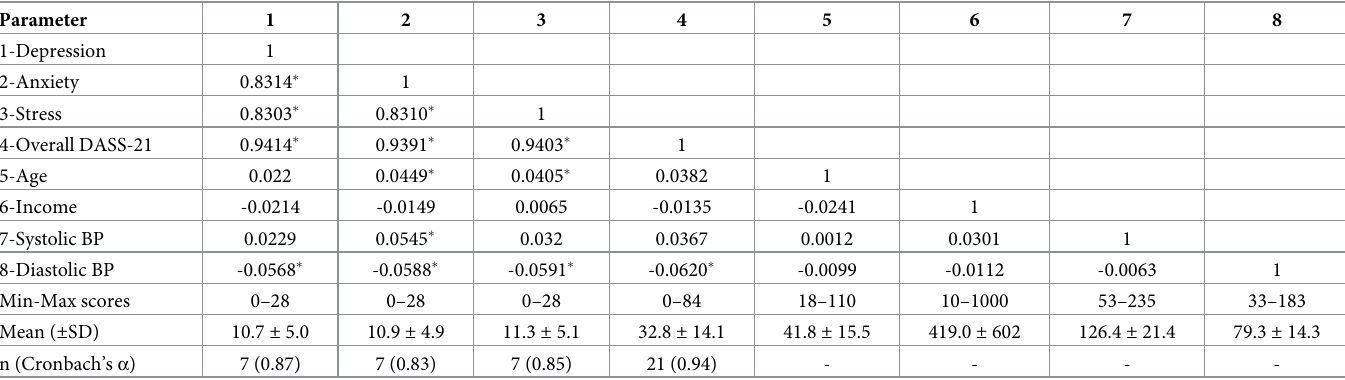
Table 2. Correlations, means, standard deviations and Cronbach’s α between background characteristics and depression, anxiety and